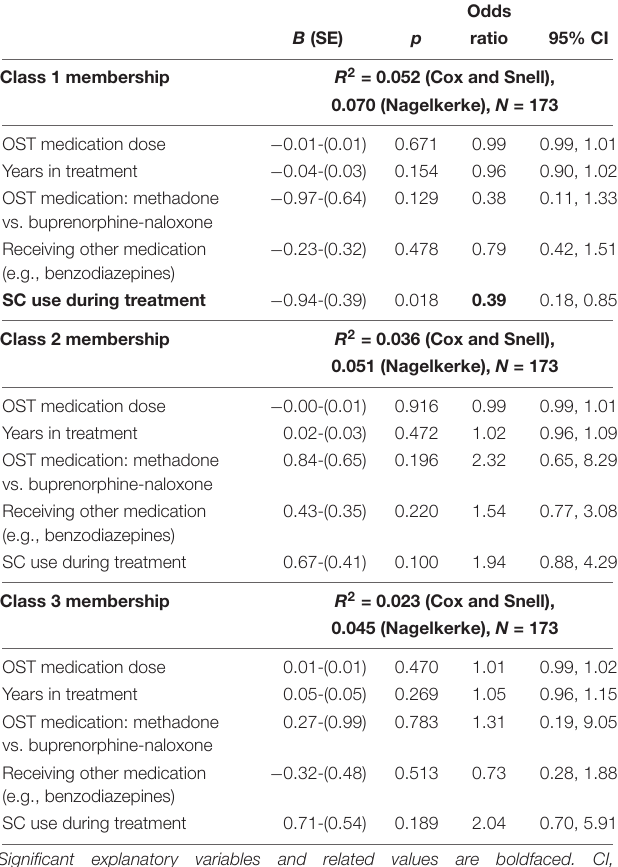
TABLE 7 | Treatment indices and SC use during treatment as predictors of latent class memberships.